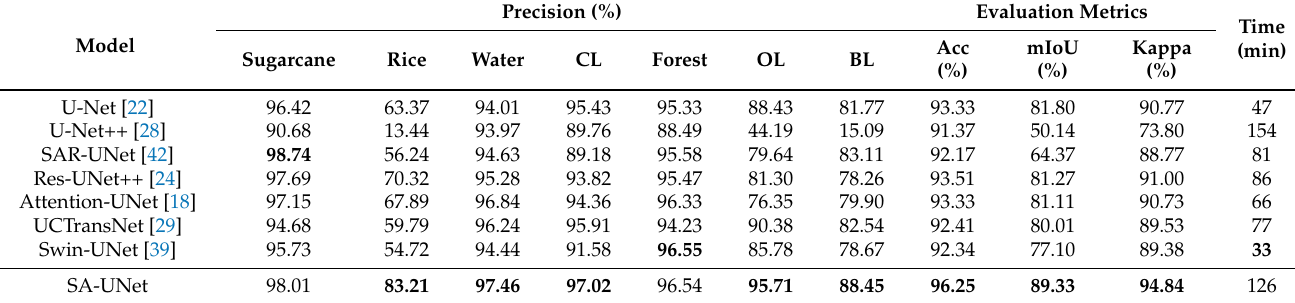
Table 5. Comparison of segmentation results of test sets in dataset I by different methods.